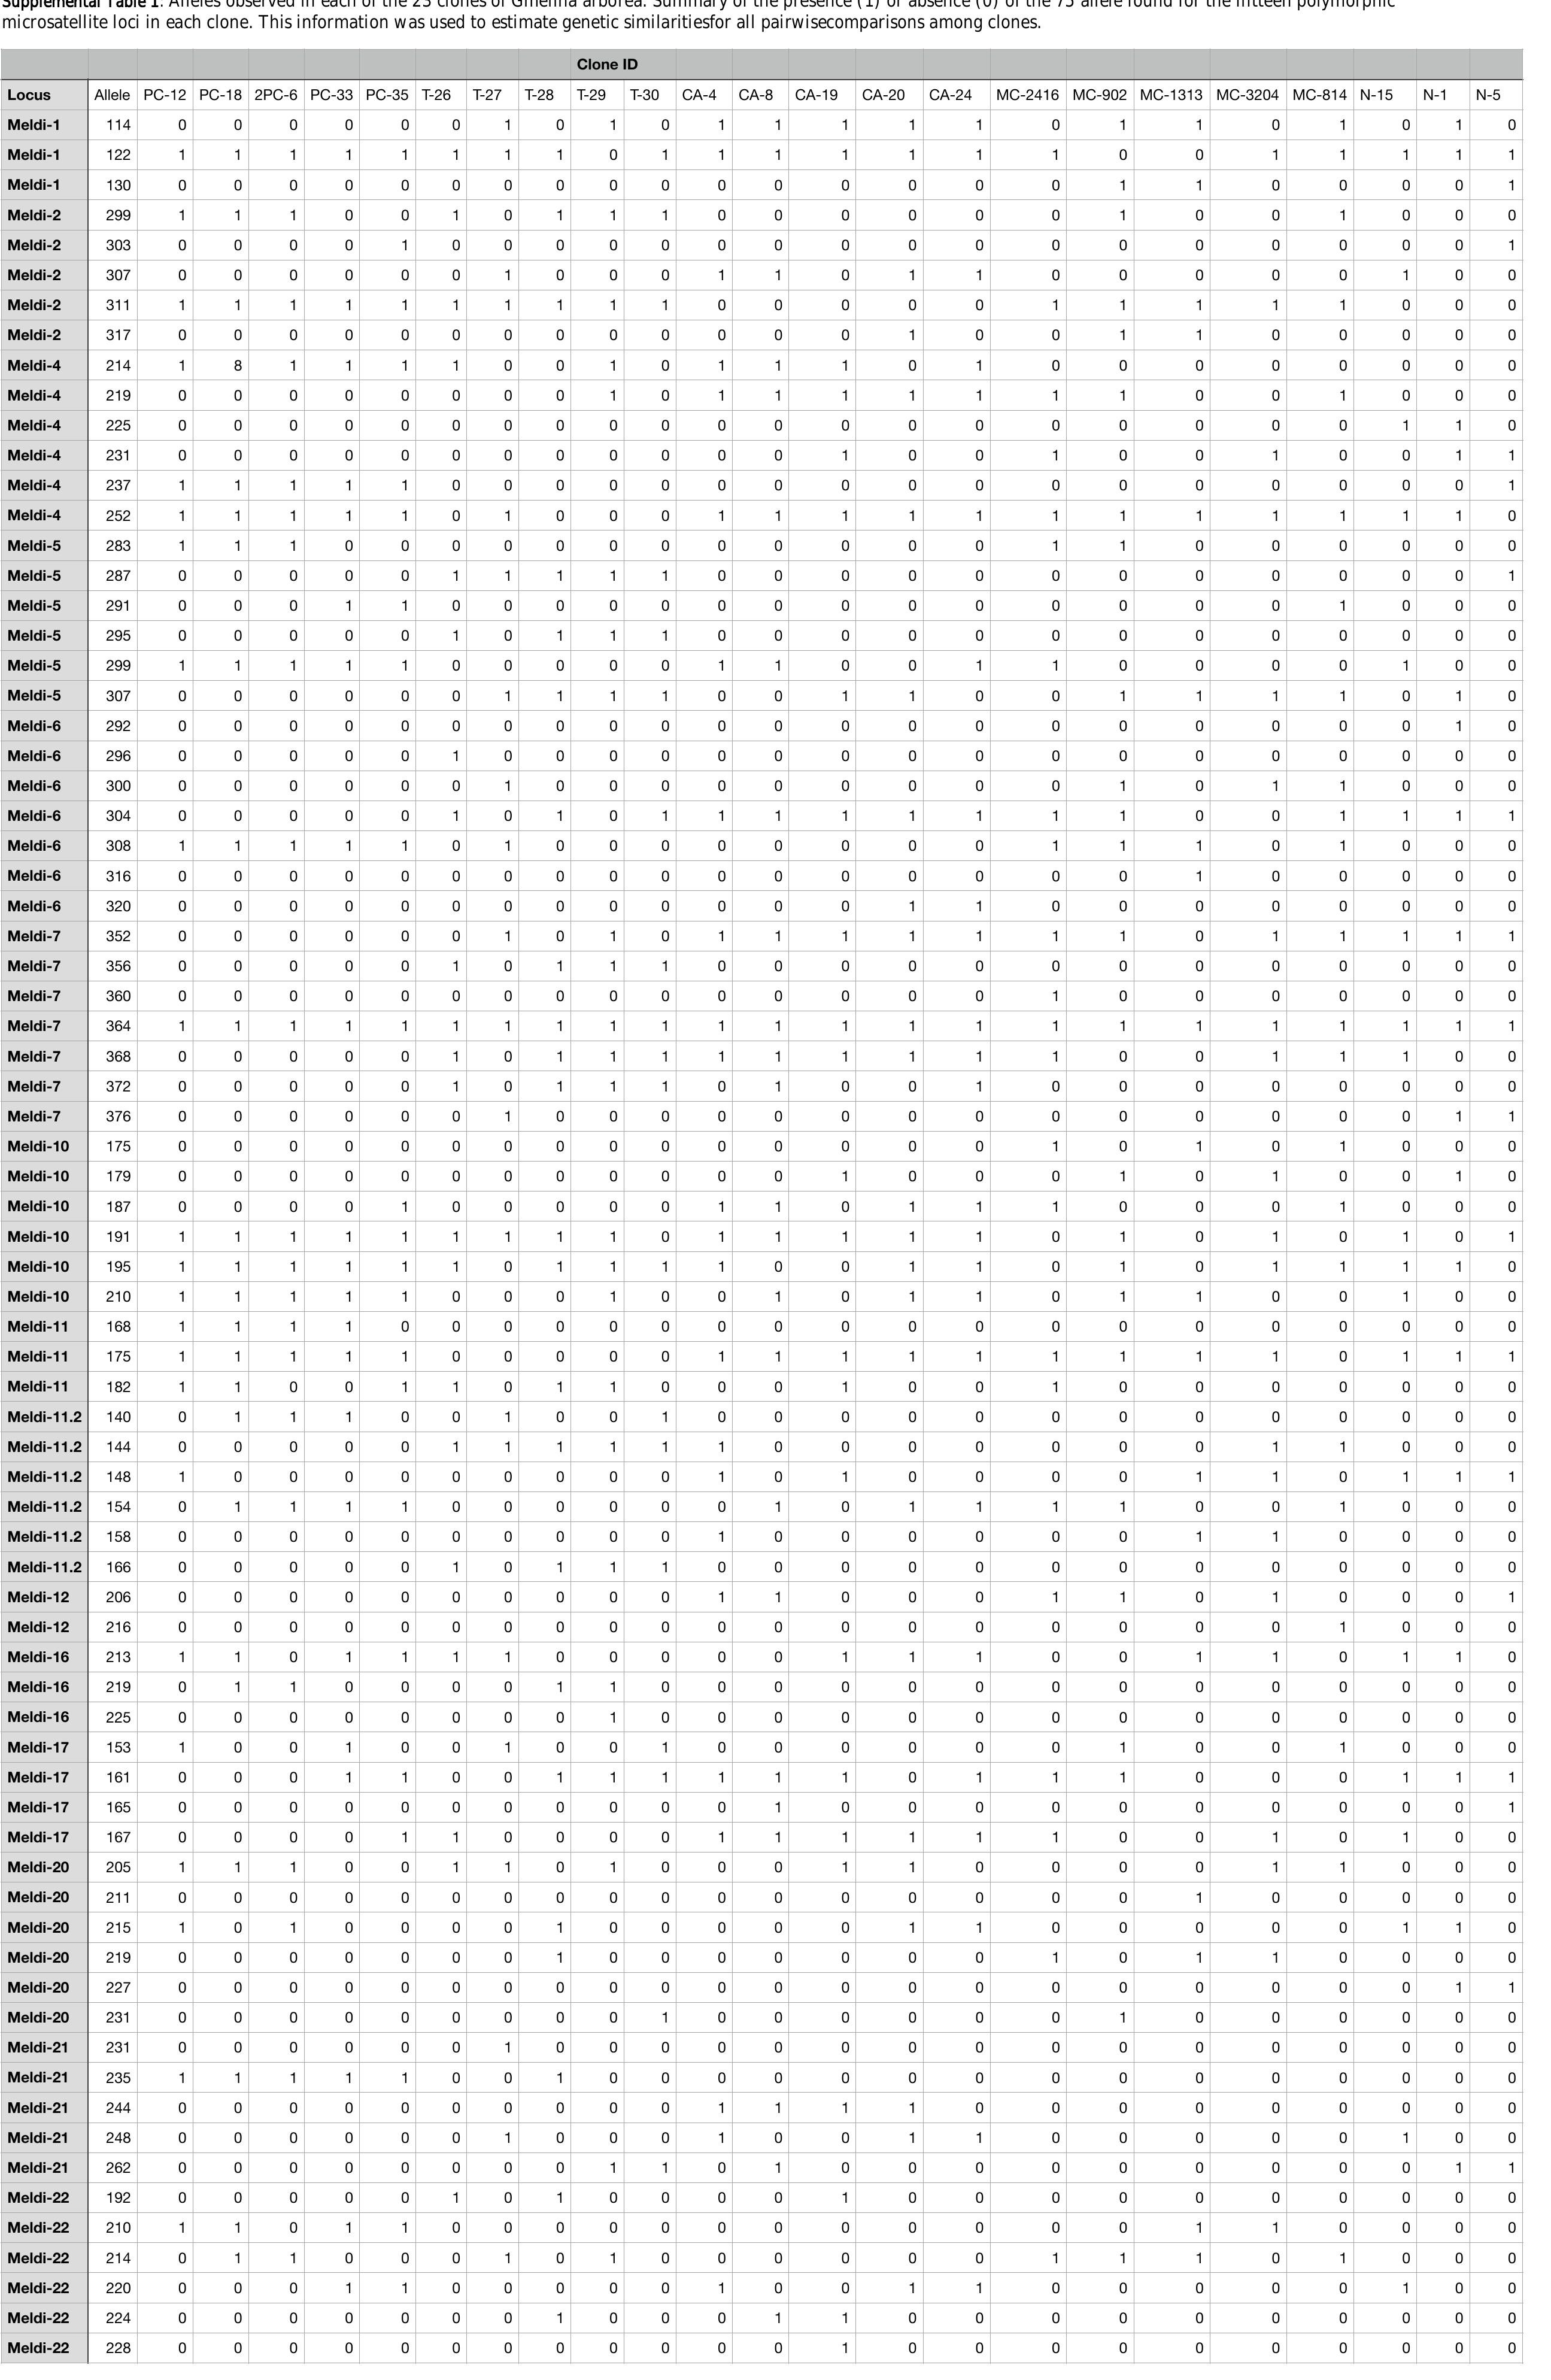
Supplemental Table 1: Alleles observed in each of the 23 clones of Gmelina arborea. Summary of the presence (1) or absence (0) of the 75 allele found for the fiftteen